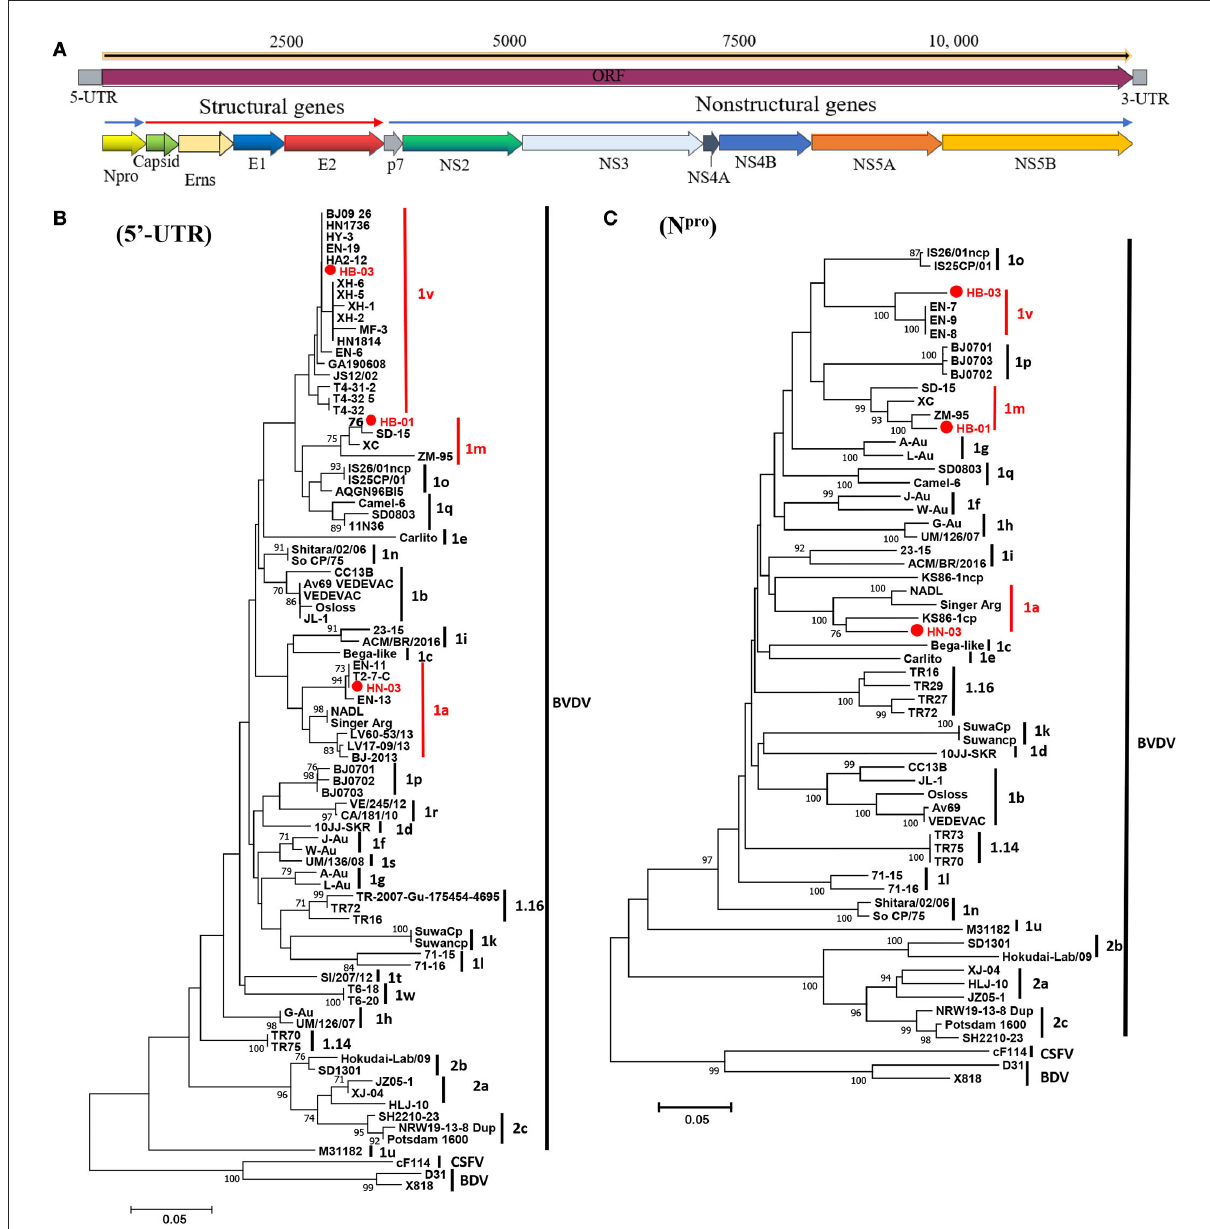
FIGURE3 Schematic diagram of the genomic structure and phylogenetic analysis. Schematic diagram of the annotated bovine viral diarrhea virus (BVDV) genome (A) . Phylogenetic tree of the nucleotide sequences of the 5-untranslated region (5 ′ -UTR) (B) and N pro (C) . Molecular evolutionary genetics analysis was performed with MEGA 7 (Molecular Evolutionary Genetics Analysis) using the neighbor-joining (NJ) and bootstrap analysis ( n = 1,000) method. Unrooted trees described the relationship between sequences retrieved pestivirus [BVDV-1, BVDV-2, classical swine fever virus (CSFV), and border disease virus (BDV)] from the GenBank database and the three BVDV isolates analyzed in this work (red circle). Information on the reference strains is shown in Supplementary Table 3.